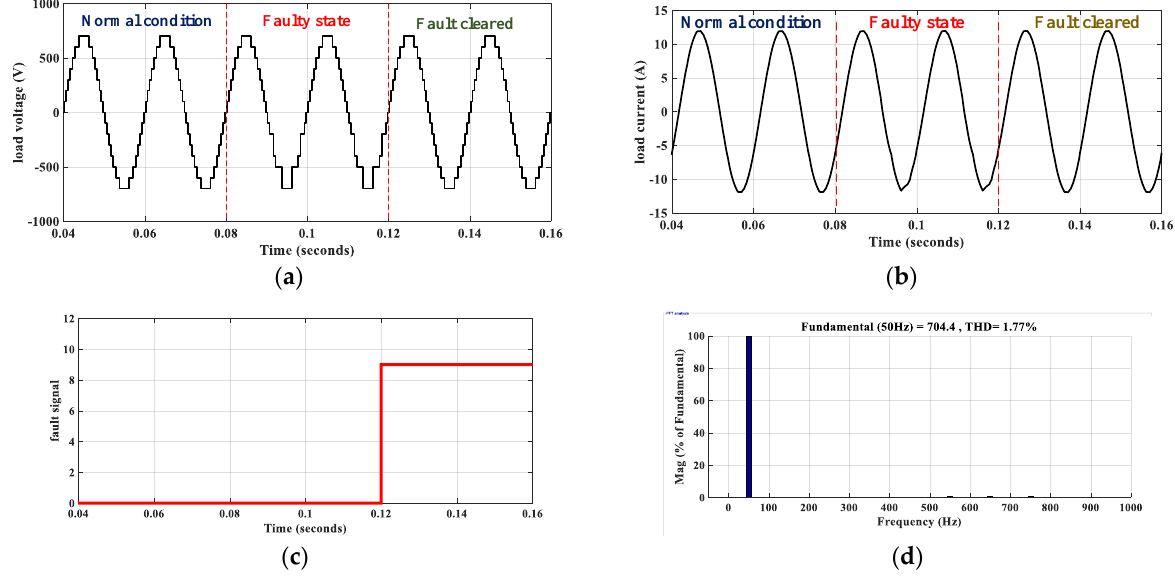
Figure 5. Simulation results for S 9 fault for ( a ) load voltage, ( b ) load current, ( c ) fault detection signal, and ( d ) voltage harmonics profile.